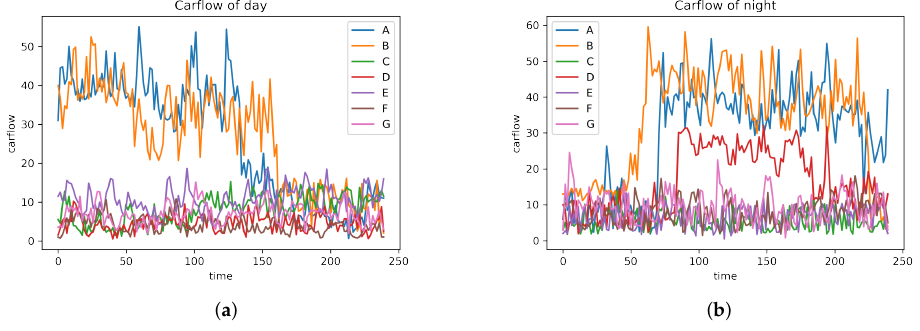
Figure 10. Traffic flow at seven real intersections. ( a ) Morning rush hour: 8:00 to 9:00; ( b ) Evening rush hour: 17:30–18:30.